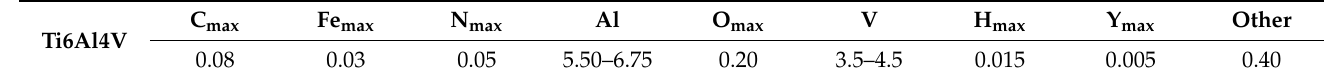
Table 3. Chemical Composition of TI6Al4V %wt.